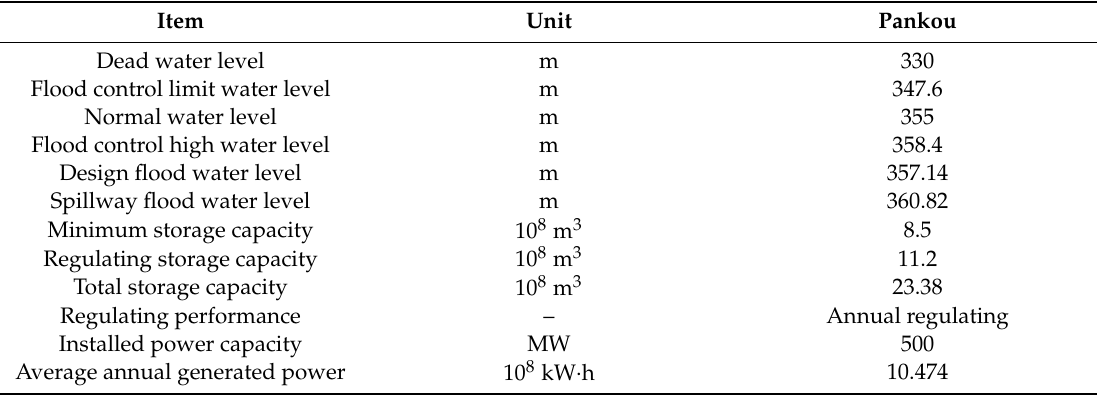
Table 3. Basic information of the Pankou reservoir.